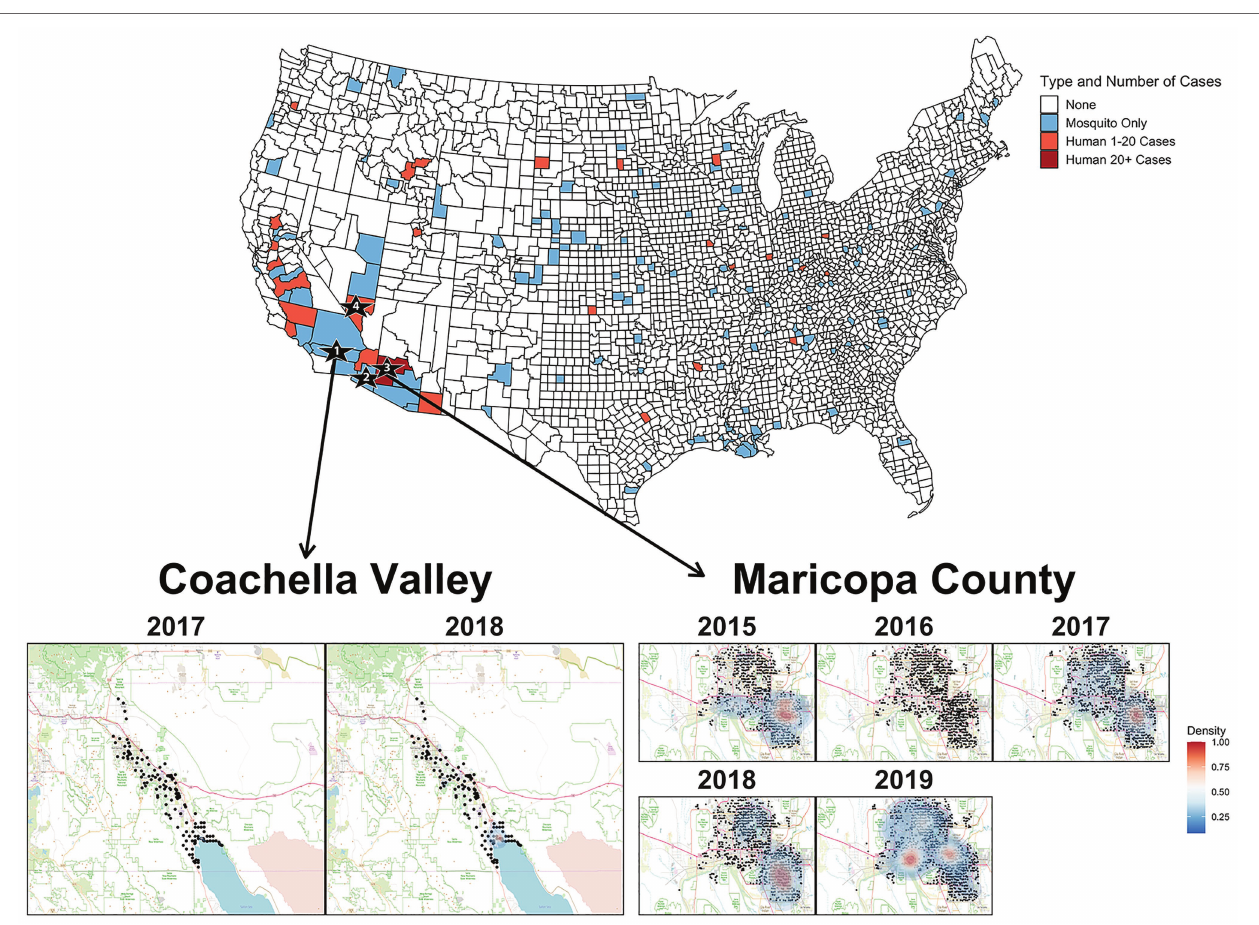
FIGURE 2 | The United States map colors counties where SLEV positive mosquitoes or human cases were observed between 2015 and 2019. Sampling locations for the genomes sequenced in this study are indicated by the numbered black stars. Star 1 is Coachella Valley, Star 2 is Yuma County, Star 3 is Maricopa County, and Star 4 is Clark County. Heat map of densities of positive mosquito traps found within Coachella Valley from 2015 to 2018 and Maricopa County from 2015 to 2019. The black points represent the individual mosquito trap locations. Two-dimensional kernel density estimation with axis-aligned bivariate normal kernel was used to estimate the density of positive mosquito traps within each year. Red indicates a higher density of positive